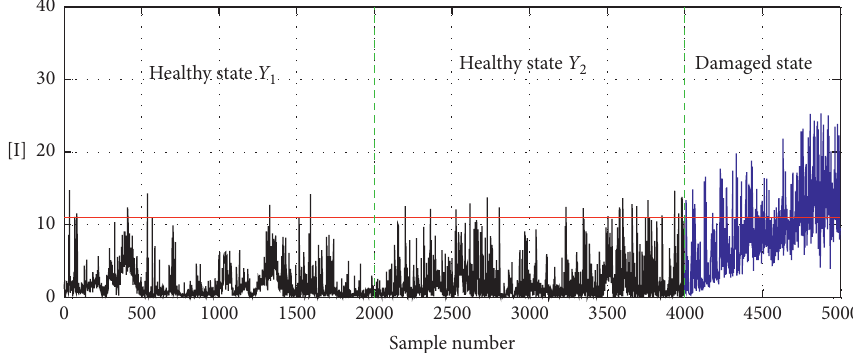
Figure 7: Condition assessment results of the proposed method.